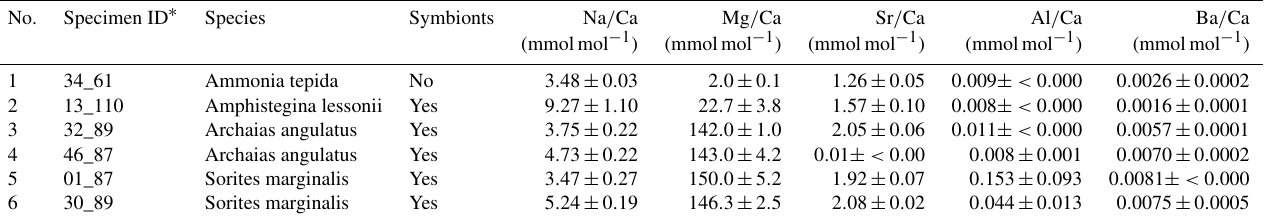
Table A1. Additional information on specimens. LA-ICP-MS data of average single shell El / Ca ratios were determined on several chambers. No.